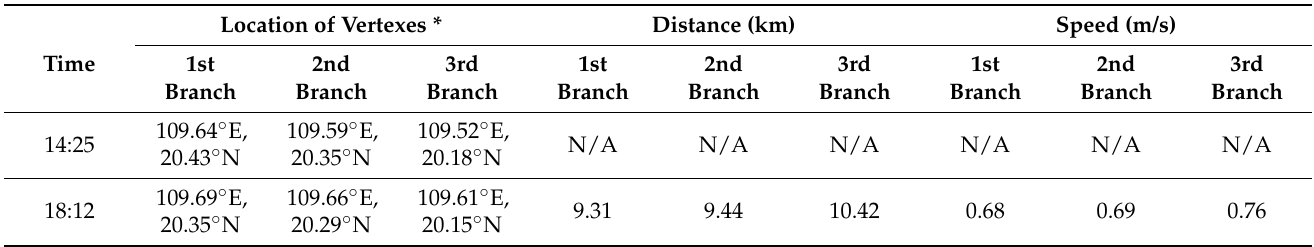
Table 2. Statistics of the movement of trident-shaped warm water